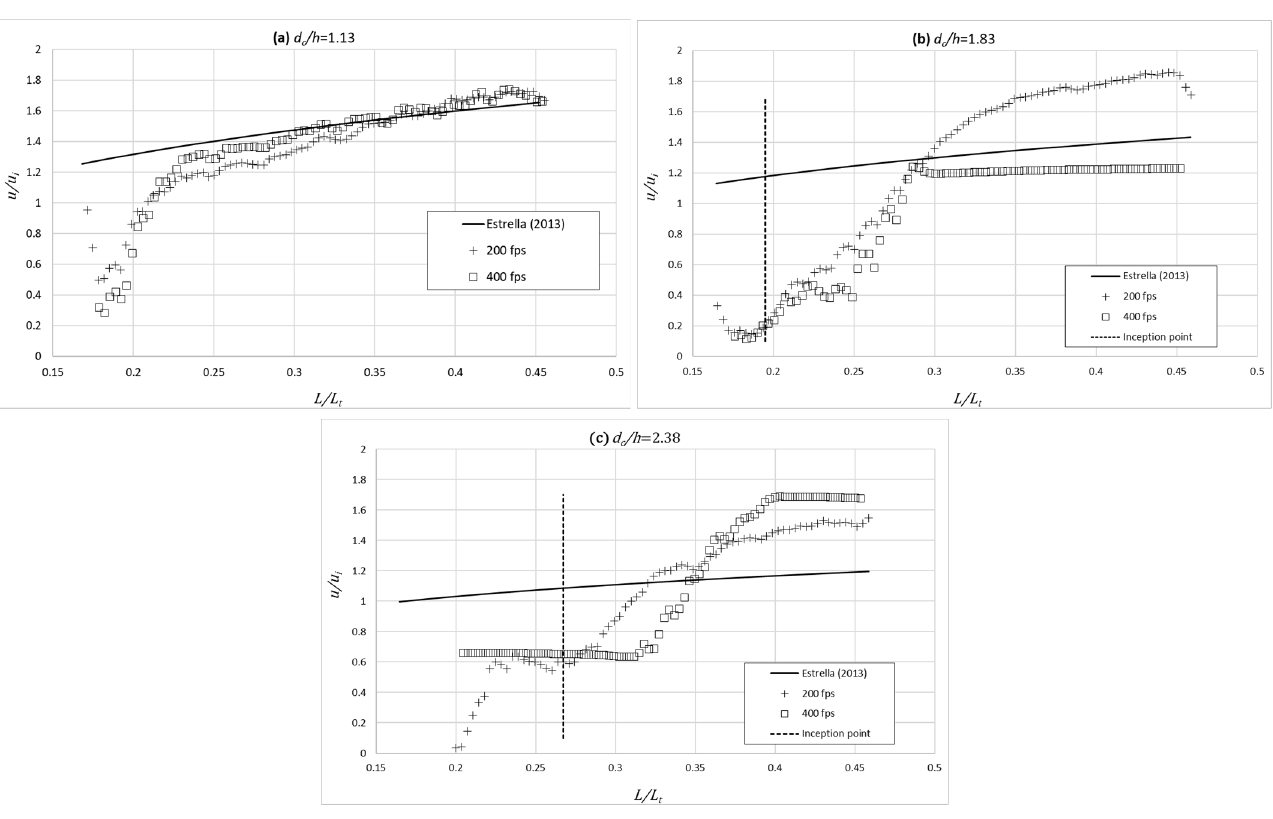
Figure 15. Velocity field obtained for 400 fps and ( a )   /ℎ = 1.13 and ( b )   /ℎ = 1.83 .